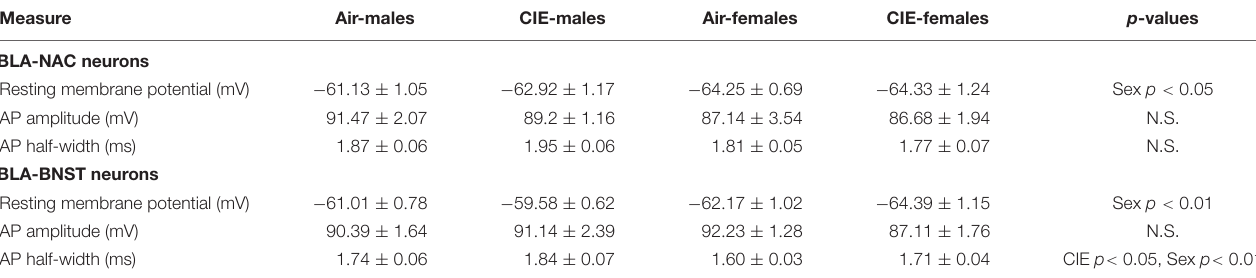
TABLE 1 | Cellular membrane properties.